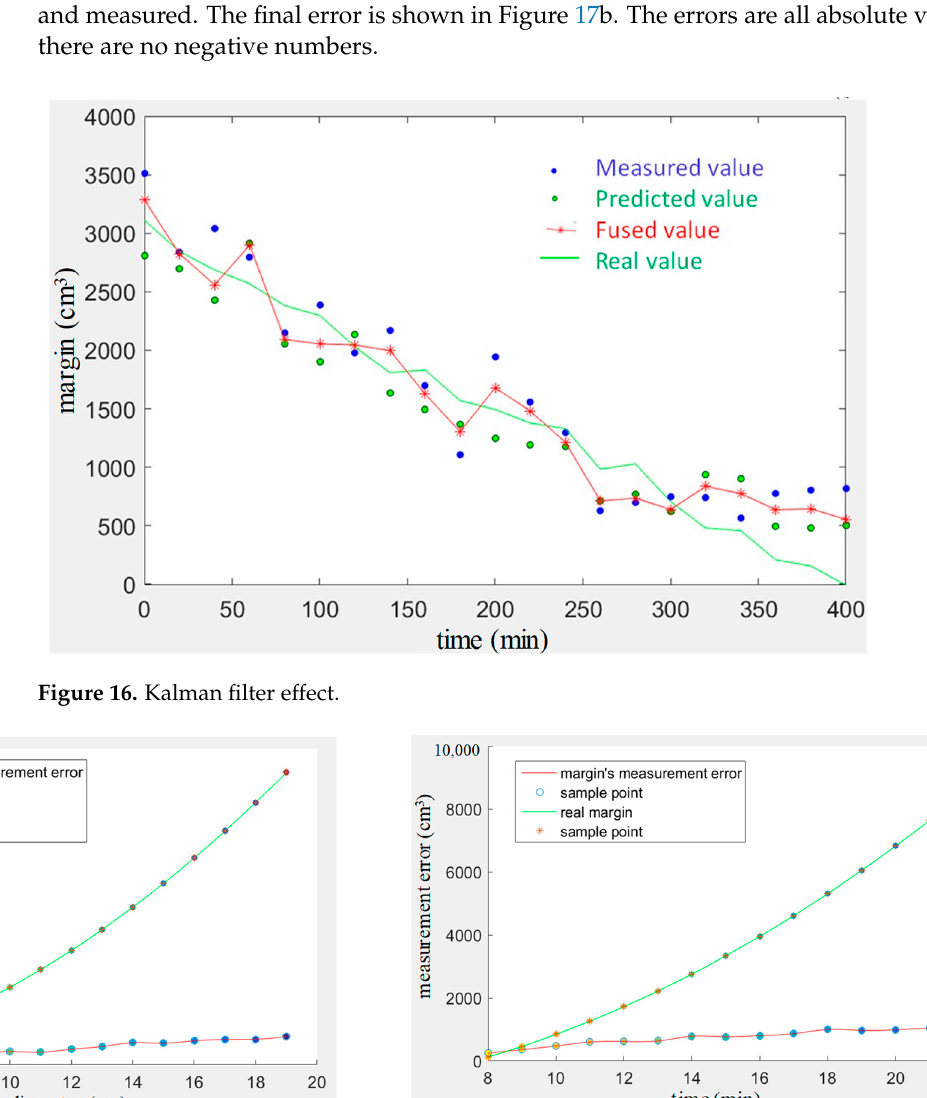
Figure 15. Yarn roll’s length measurement error.